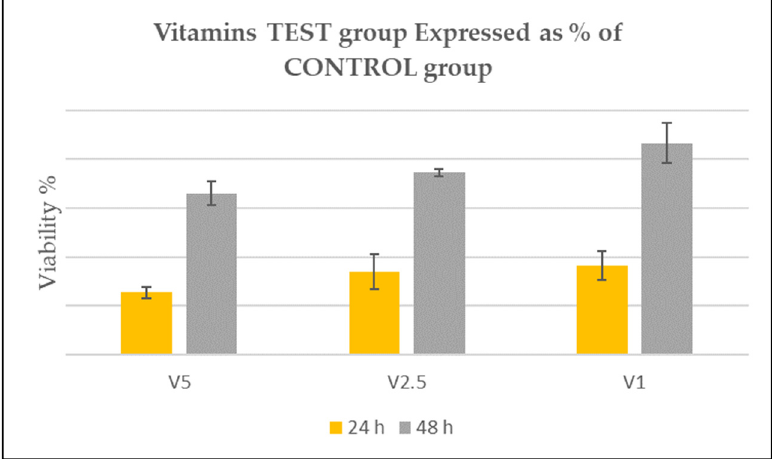
Figure 4. Vitamin test groups. Graphic shows the viability of the TEST groups. According to ISO